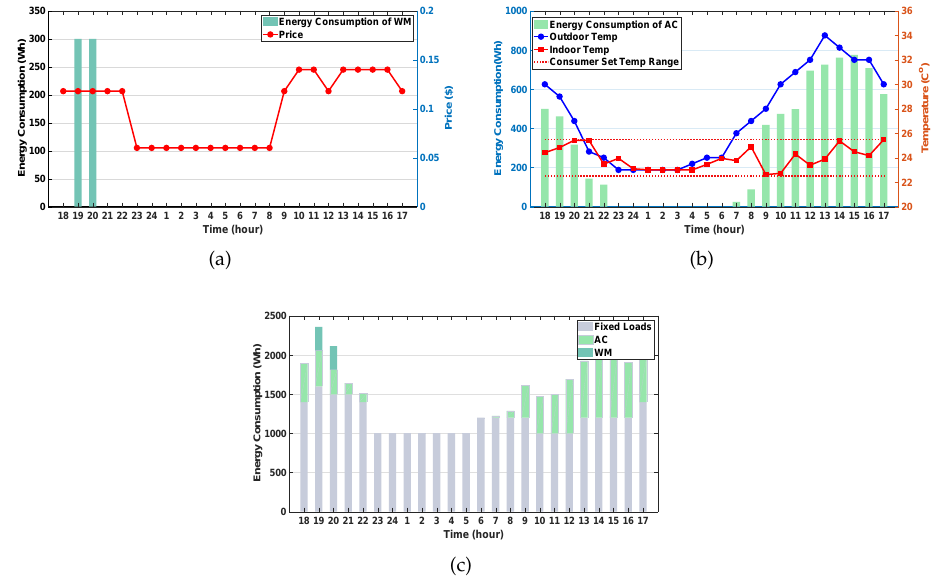
Figure 4. DRL-based energy consumption schedule. ( a ) washing machine (WM); ( b ) air conditioner (AC); ( c ) WM+AC+Uncontrollable appliances at Level